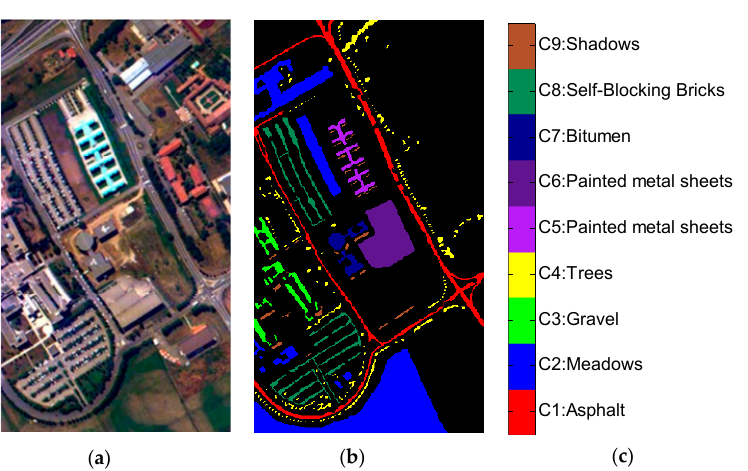
Figure 4. Pavia University dataset with ( a ) original hyperspectral image, ( b ) ground truth, and ( c ) category names with labeled samples.